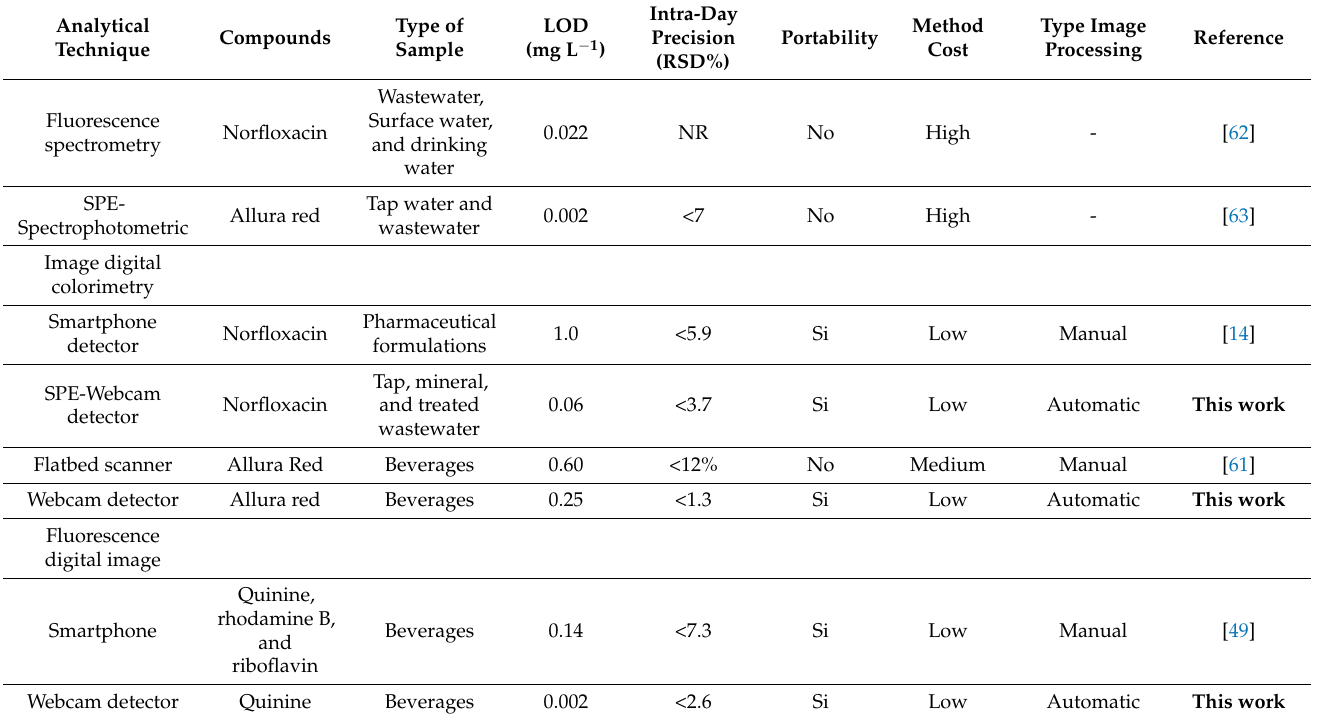
Table 4. Comparison of the system developed with other analytical methods for the determination of norfloxacin, allura red, and quinine in environmental and food samples,